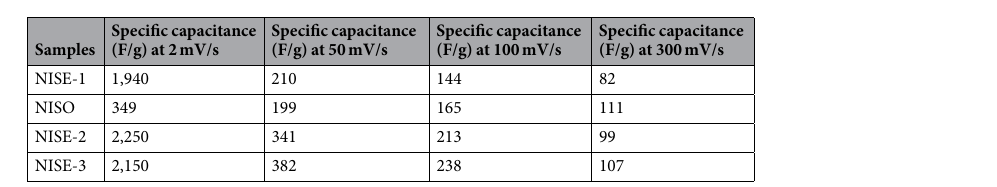
Table 1. The specific capacitance of synthesized samples at various scan